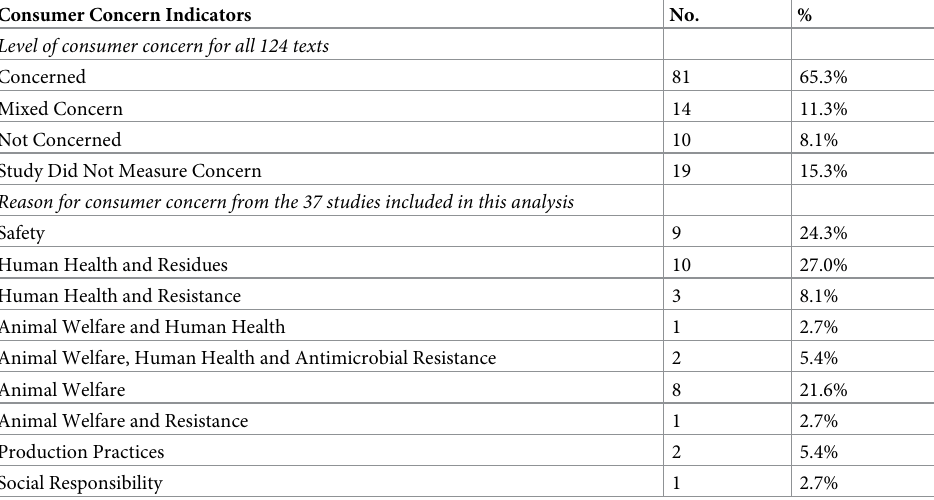
Table 4. Characteristics of studies that measured level of concern and reasons for